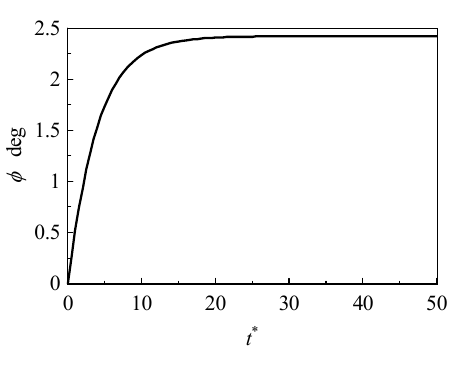
Fig.5 Transient behavior of director angle φ at upper plate for Er=500 and Ae=100